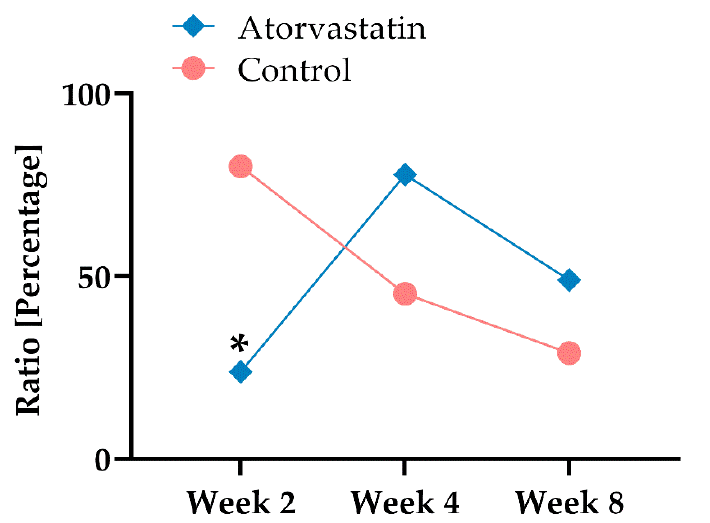
Figure 7. Percentage of myofibroblasts in relation to the total cell count of the posterior capsule (*: p < 0.01 to respective control).